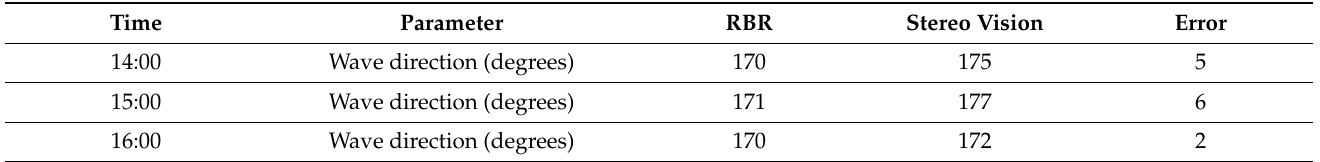
Table 8. Measurement accuracy verification of wave